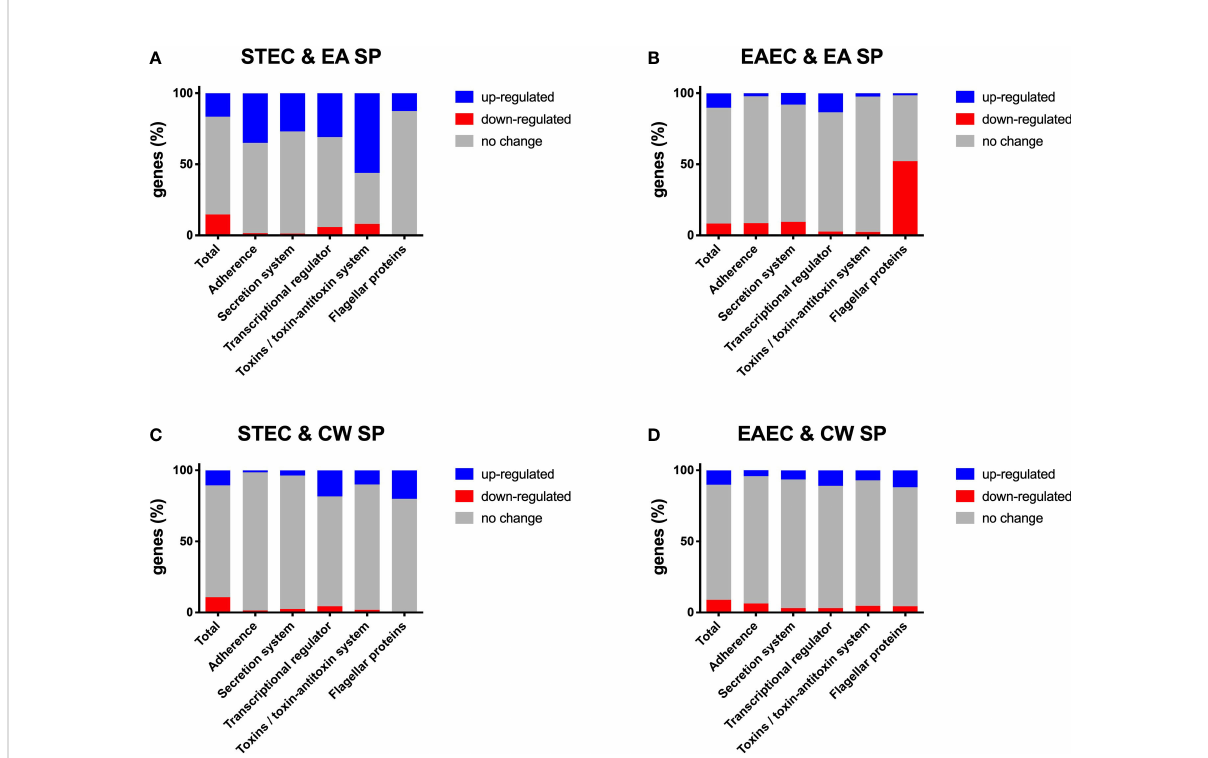
FIGURE 1 Changes in gene expression, grouped by category, for DEC pathotypes incubated with EA SP or CW SP. Percentage of genes in STEC (A, C) and EAEC (B – D) where a change was noted in gene expression after incubation with EA SP (A, B) or CW SP (C, D) compared to incubation with M9 medium. Changes observed in gene expression were organized according to their role during the pathogenic